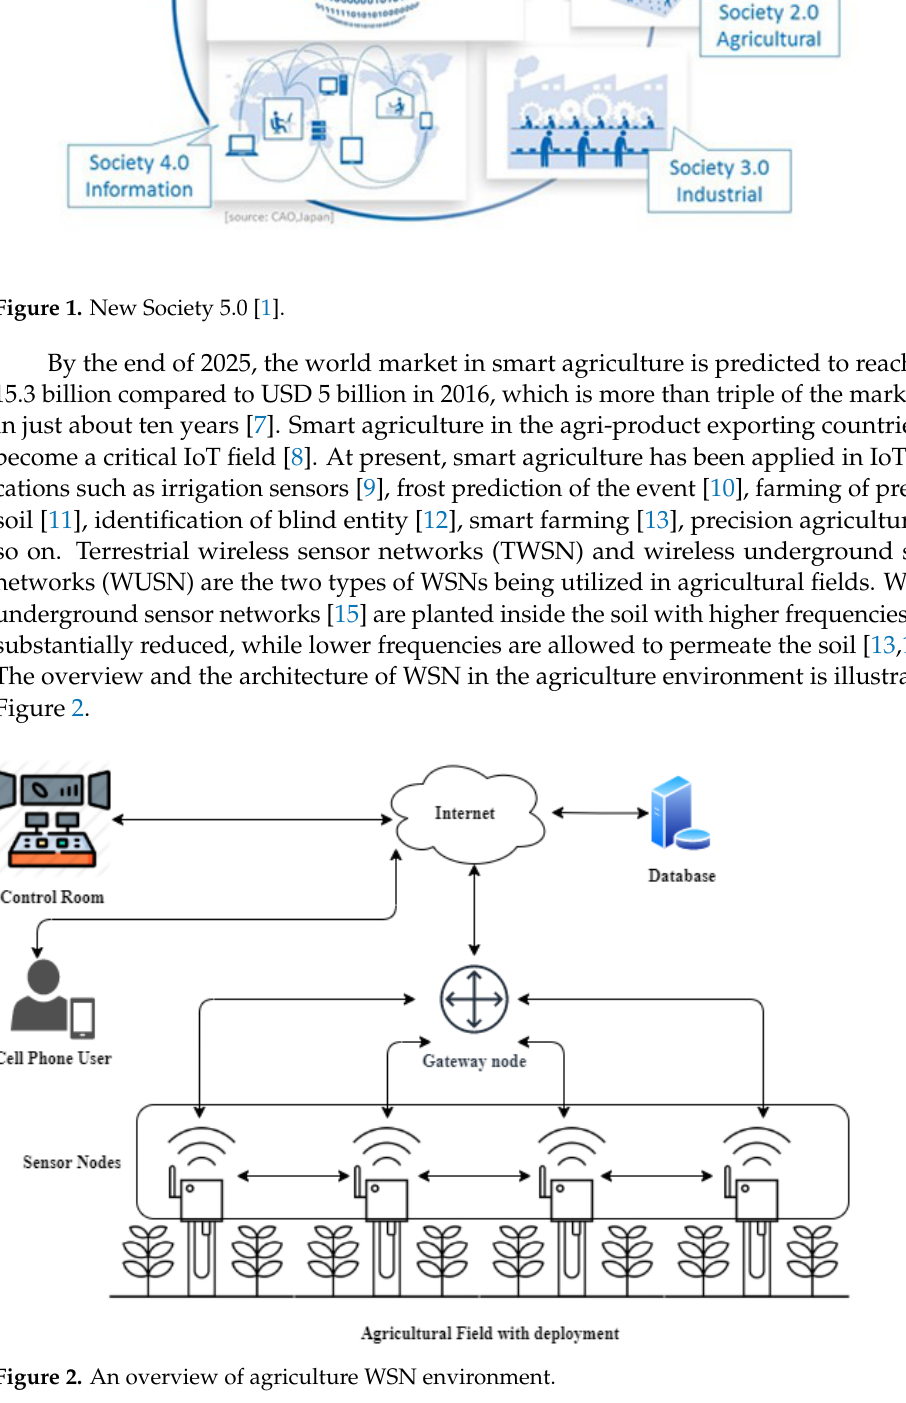
Figure 2. An overview of agriculture WSN